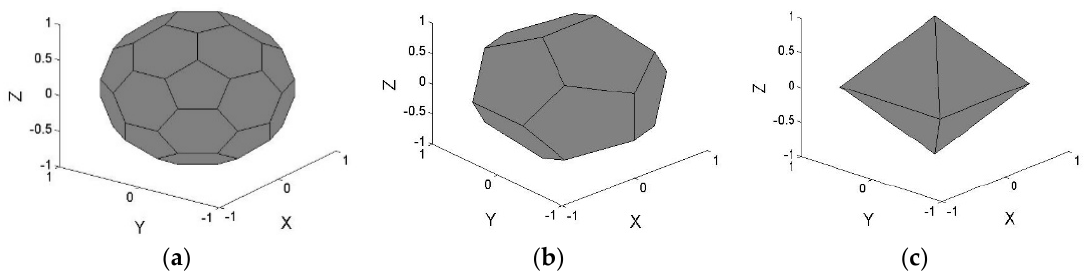
Figure 4. Three types of polyhedrons. ( a ) 32-hedron; ( b ) Dodecahedron; ( c ) Octahedron.